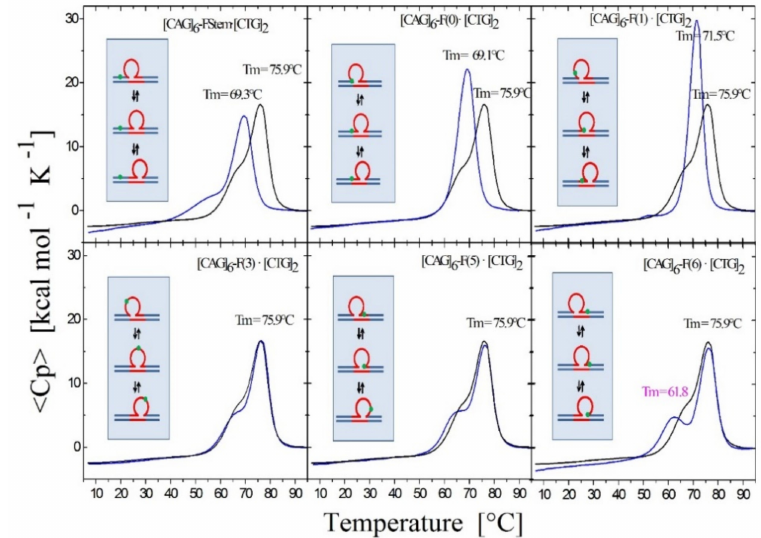
Figure 4. Excess heat capacity curves measured for the [CAG]6-F(n) · [CTG]2 constructs (F = Tetrahydro Furan abasic site analogue) for di ff erent lesion positions within the repeat domain F(n), where F replaces the dG in the nth CAG repeat counting from the 5 (cid:48) end. The lesion free parent construct (black) is the same in all panels, blue curves correspond to abasic site (F) lesions in the CAG strand. A schematic representation of the di ff erent lesion position relative to the three possible loop isomers (green dot) is shown as the insert in each